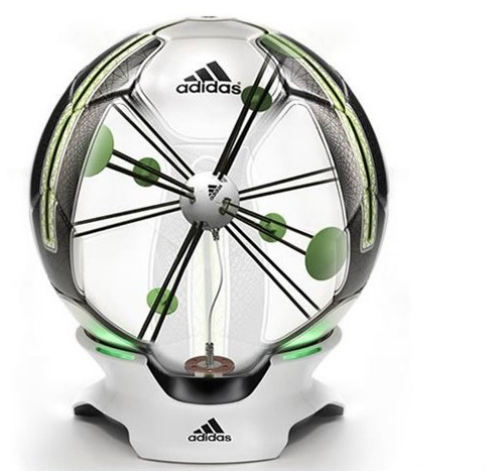
Figure 2. Adidas MiCoach Smart Ball